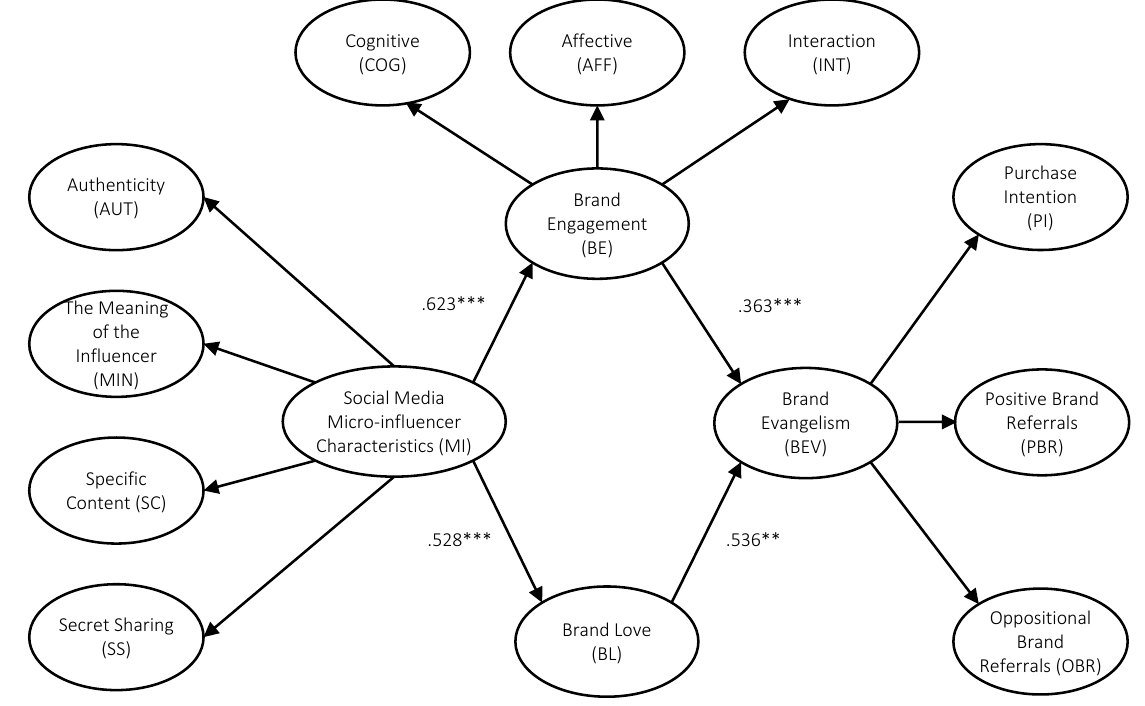
Figure 2. Structural model analysis